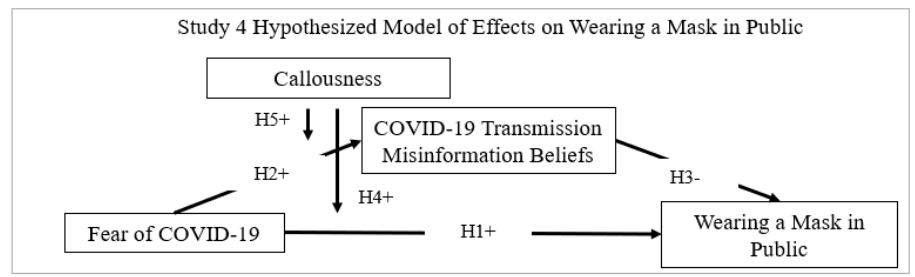
Figure 1. Study 4 hypothesized model of effect on wearing a mask in public.